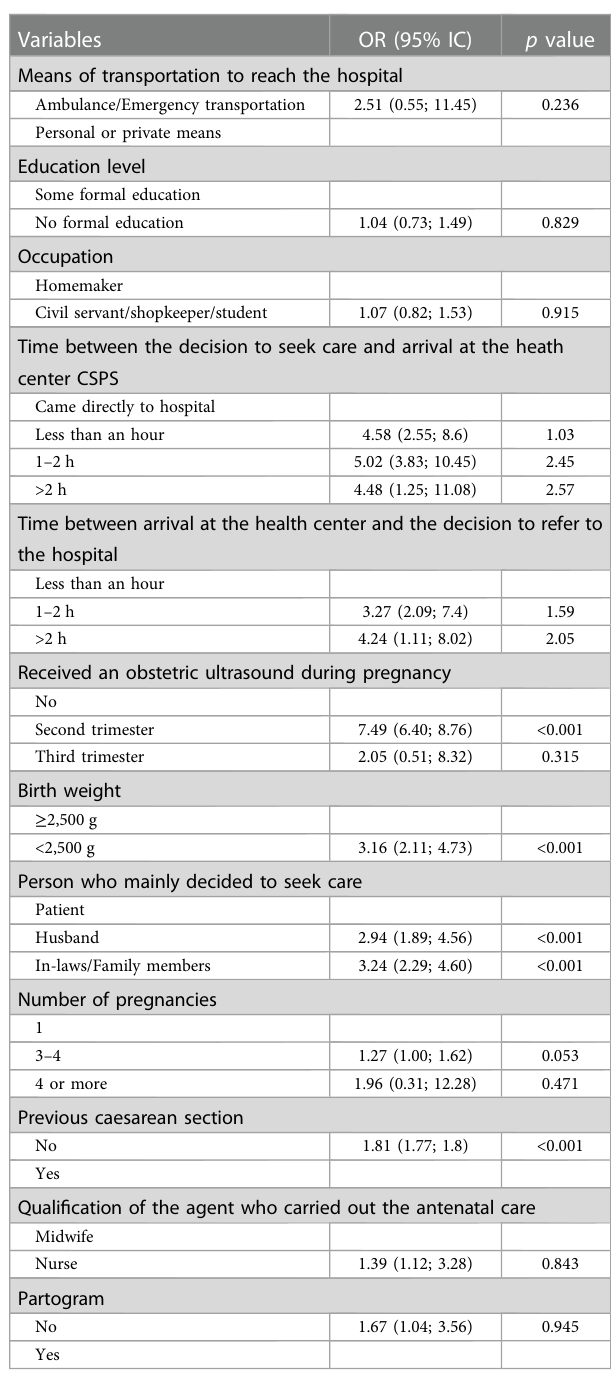
TABLE 5 Multivariate analysis of variables associated with intrapartum